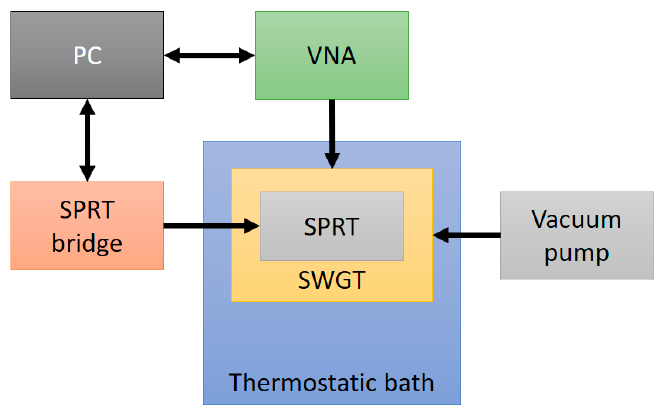
Figure 5. Schematic of the measurement setup. The SWGT was hosted in a thermostatic bath and the microwave resonator was connected to the vacuum pump. The WGM resonant frequencies were detected by a VNA while a SWGT reference temperature was measured by a SPRT and a precision thermometry bridge. Both the VNA and the resistance bridge were controlled by a PC.